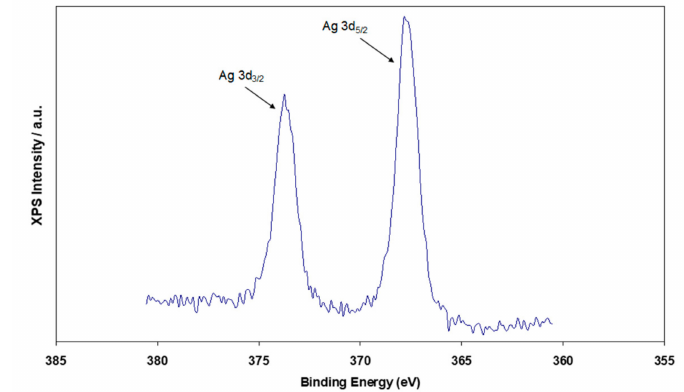
Figure 10. Ag3d XPS spectrum of